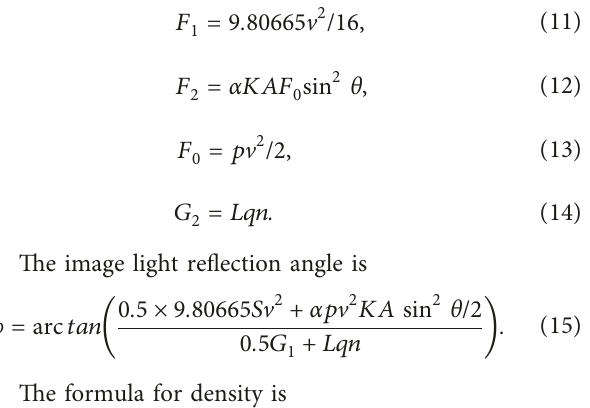
Figure 4: Local features of monitoring image strings in ideological and political classrooms.